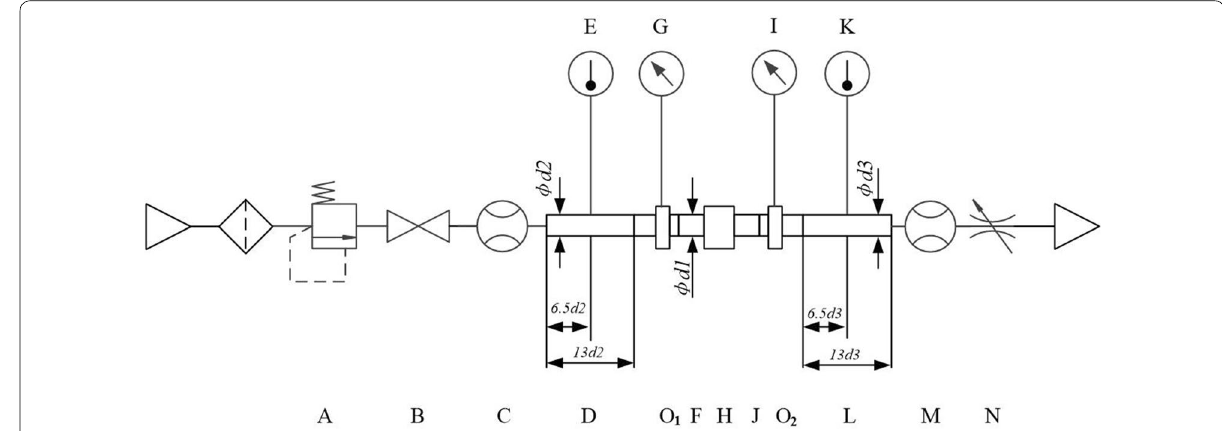
Figure 2 Circuit which is used for exhaust-to-atmosphere test